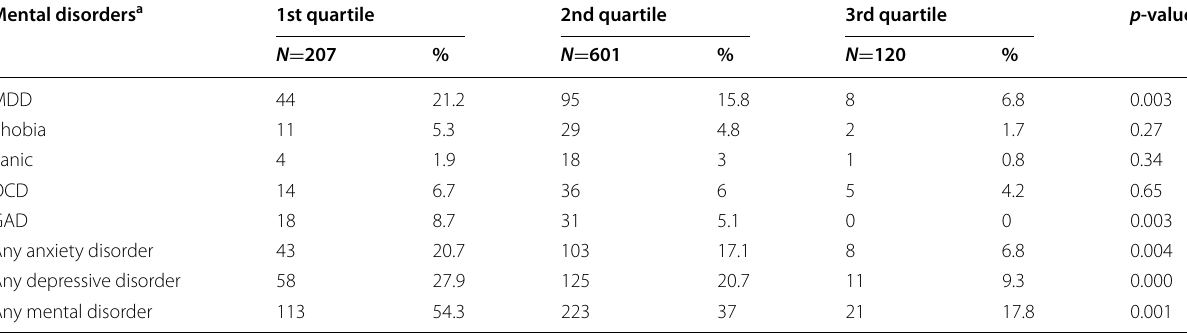
a Some participants had more than one disorder. Therefore, the total number of disorders was more than the total number of